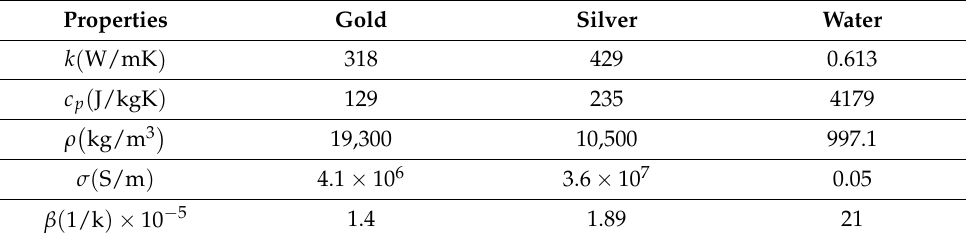
Table 1. Thermophysical properties of nanoparticles and base fluid [50,51].